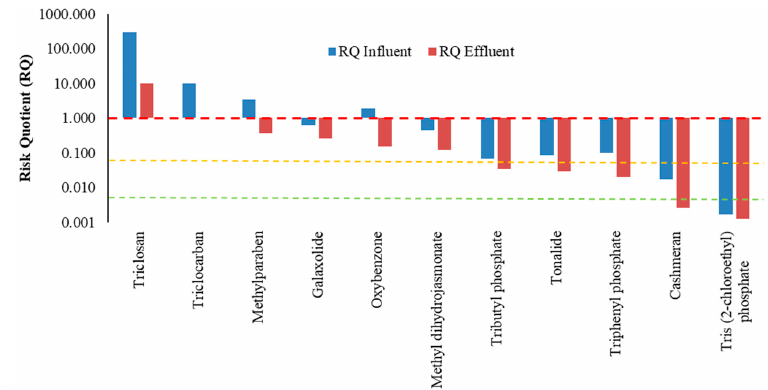
Figure 2. Risk quotient of the 11 selected PCPs based on influent and effluent concentration in constructed wetlands (CWs). Note: risk is categorized into four levels: high risk (RQ > 1.0; above red line), medium risk (0.1 ≤ RQ ≤ 1.0; between red and orange line), low risk (0.01 ≤ RQ ≤ 0.1; between orange and green line), and no risk (RQ < 0.01; below green line) (For interpretation of the references to colour in this figure legend, the reader is referred to the web version of this article). Int. J. Environ. Res. Public Health 2020 , 17 , x Table 2. Risk assessment of 11 selected PCPs based on influent and effluent concentration in CWs.